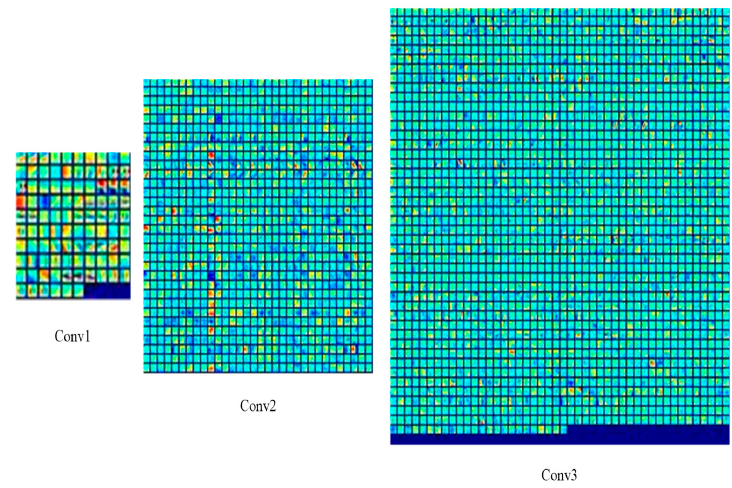
Figure 4. The weights visualization of NCA-net’s convolution layers.